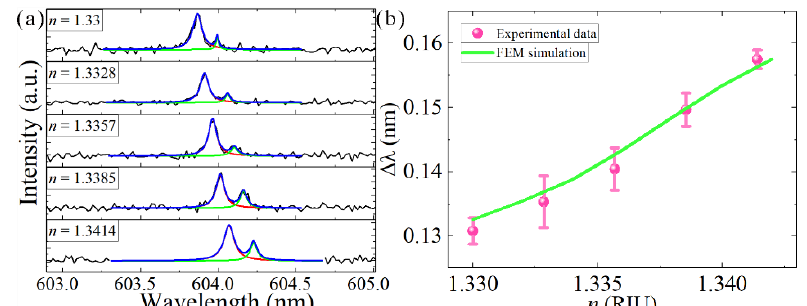
Figure 6. ( a ) Mode splitting in a coupled-microdisk resonator laser with resonance detuning. ( b ) Δ λ of the experimental data and FEM simulation, shown as a function of refractive index. Pink dots represent the experimentally detected data, while the green curves represent the FEM simulation results. FEM simulations were performed using the same parameters for the experimental data.